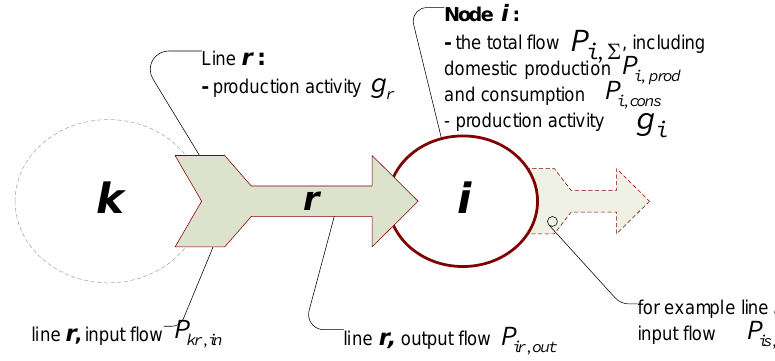
Figure 1. The products of network line [64], (p. 209).